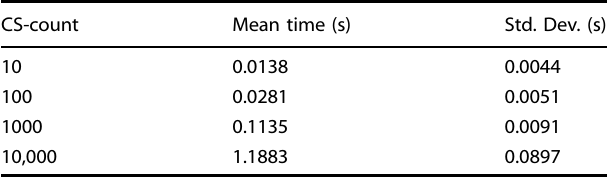
Table 2. Performance of the algorithm (in seconds) of Theorem 2.27 as implemented in our Mathematica code 38 .